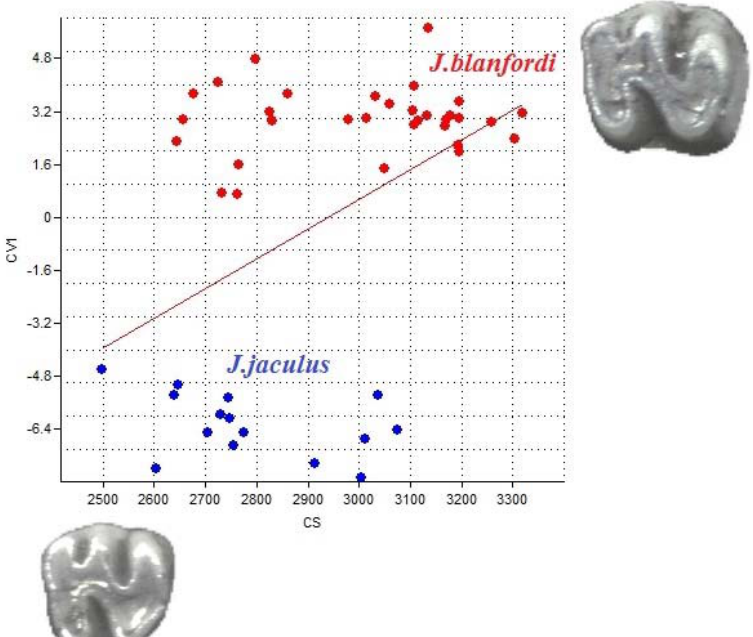
F IGURE 8. Projection of examined specimens belonging to two species based on correlation centroid size and CV axis. Heterogeneity in J.blanfordi is visible.